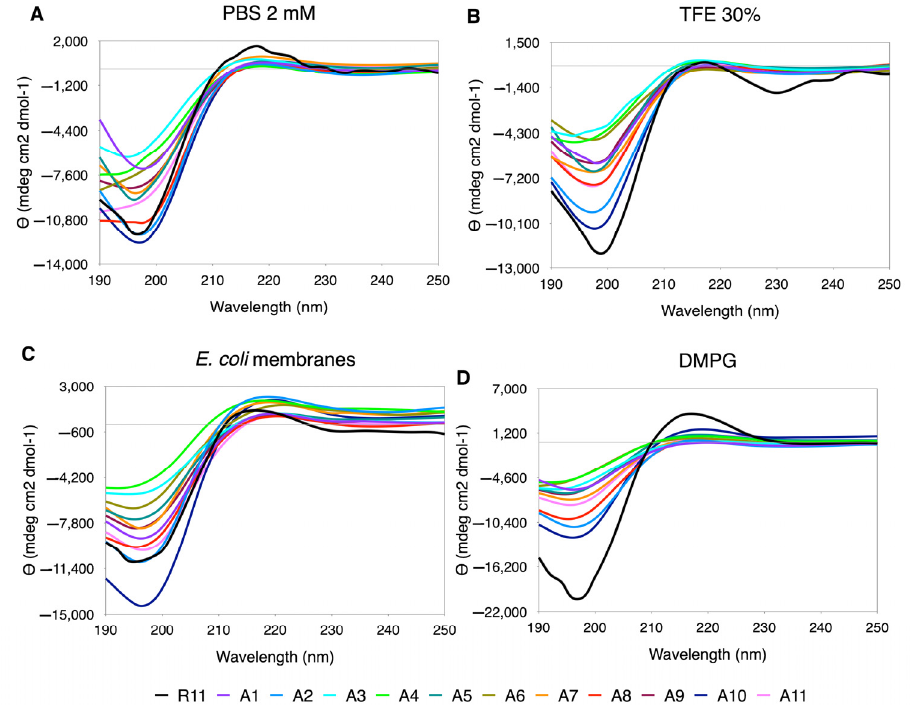
Figure 3. CD spectra for Ala scanning of R11 in the four media used. ( A ) 30% TFE. ( B ) 2 mM PBS. ( C ) DMPG. ( D ) E. coli membranes extract.